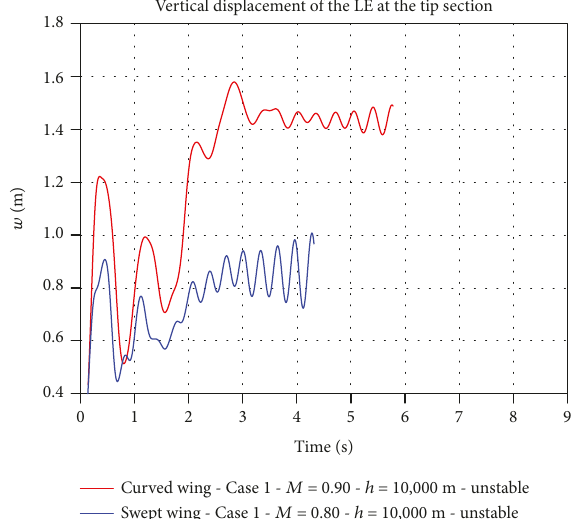
Figure 20: Damping vs. Mach (Case 1): density-based and pressure-based results.